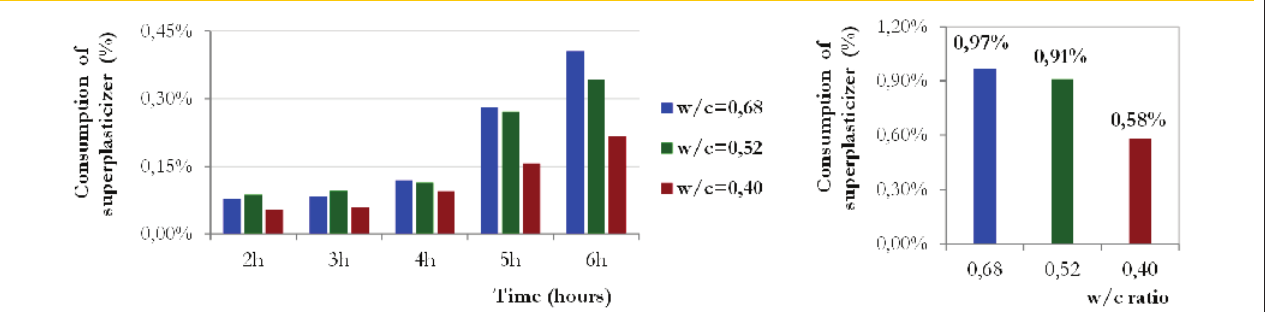
Figure 10 – Percentages of admixtures used in concrete produced in the ready-mixed concrete